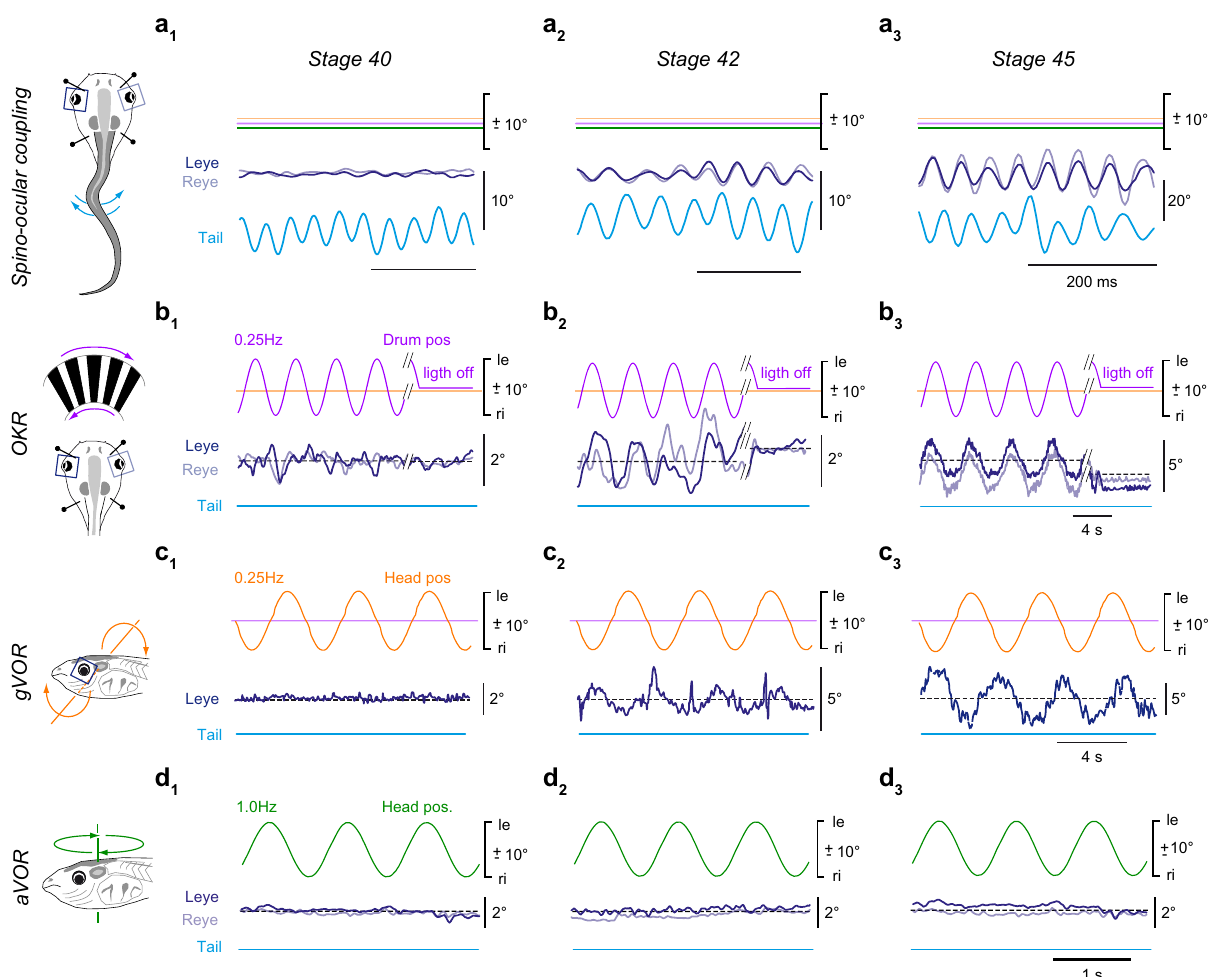
Fig. 1 Ontogeny of spino-ocular, visual motion-, otolith organ- and semicircular canal-driven eye movements. Gaze-stabilizing movements of the left (Leye) and right eye (Reye) during spino-ocular motor coupling ( a ), optokinetic re fl ex (OKR, b ) gravitoinertial (gVOR, c ) and horizontal angular vestibulo- ocular re fl ex (aVOR, d ) at stage 40 ( a 1 , b 1 , c 1 , d 1 ), stage 42 ( a 2 , b 2 , c 2 , d 2 ) and stage 45 ( a 3 , b 3 , c 3 , d 3 ). Swim episodes occurred spontaneously; OKR and gVOR were elicited by sinusoidal rotation of black/white vertical stripes or downward-upward head roll motion at 0.25 Hz with positional excursions (pos) of ±10°; during horizontal head rotation at 1 Hz with positional excursions of ±10° an aVOR was absent at developmental stages 40 – 45. le, ri, leftward, rightward